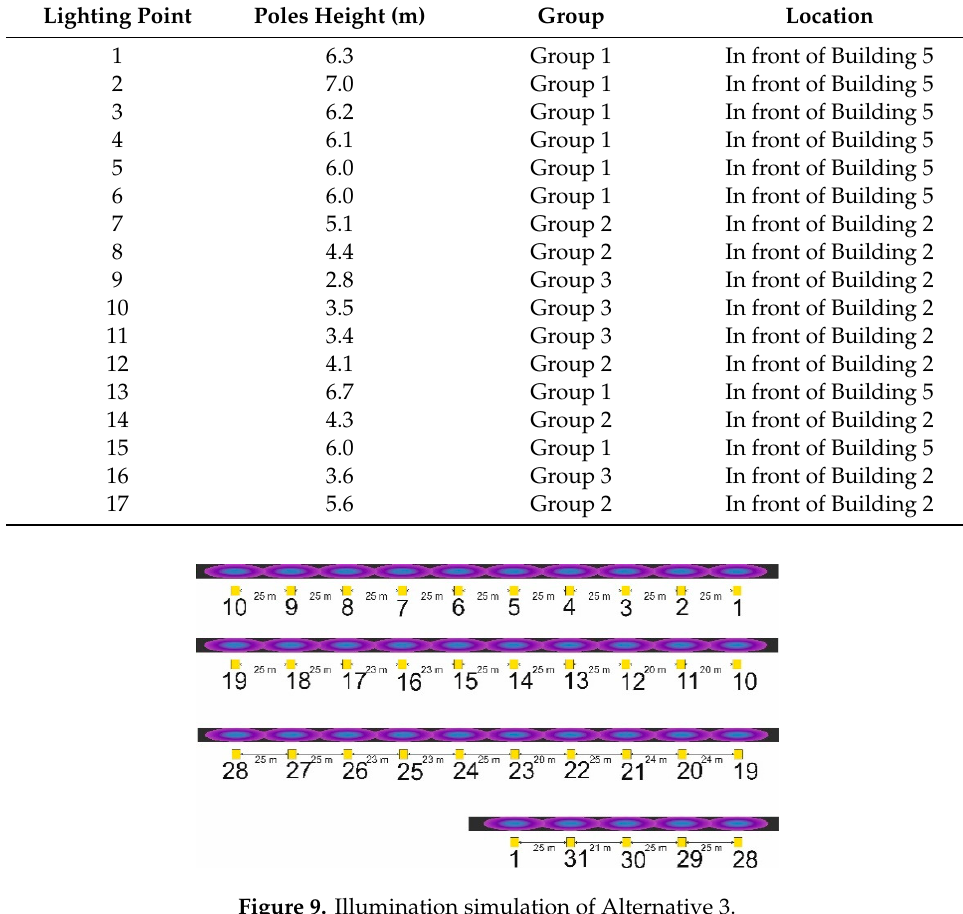
Figure 9. Illumination simulation of Alternative 3.